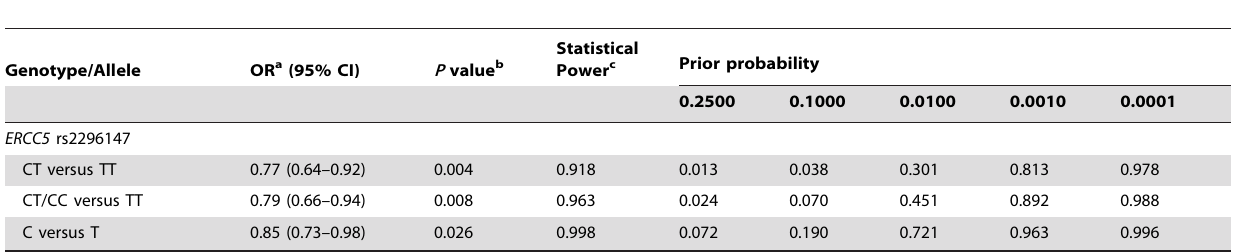
Table 5. False-Positive Report Probability Values for Associations between ESCC risk and the Frequency of Genotypes and Allele of ERCC5